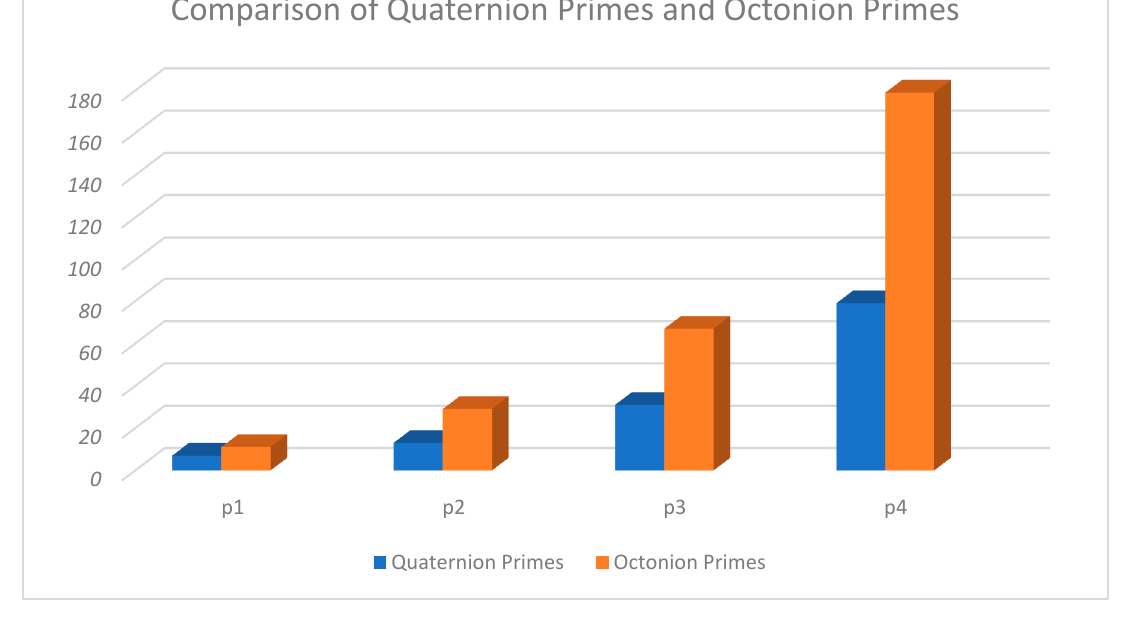
Figure 1. Quaternion Primes vs. Octonion Primes.